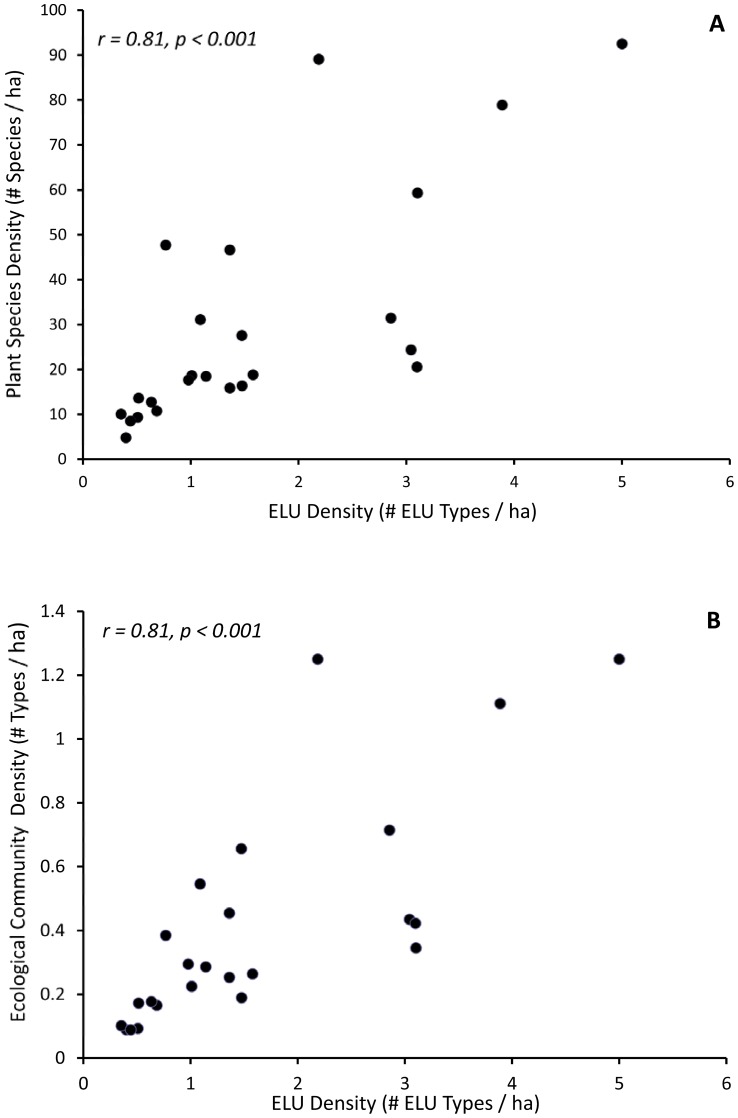
Total plant species and ecological community density versus ELU richness.(A) Total plant species density versus total number of different ELU types on ASRI refuges (standardized by refuge area in hectare). (B) Number of ecological communities on ASRI refuges versus ELU type density.